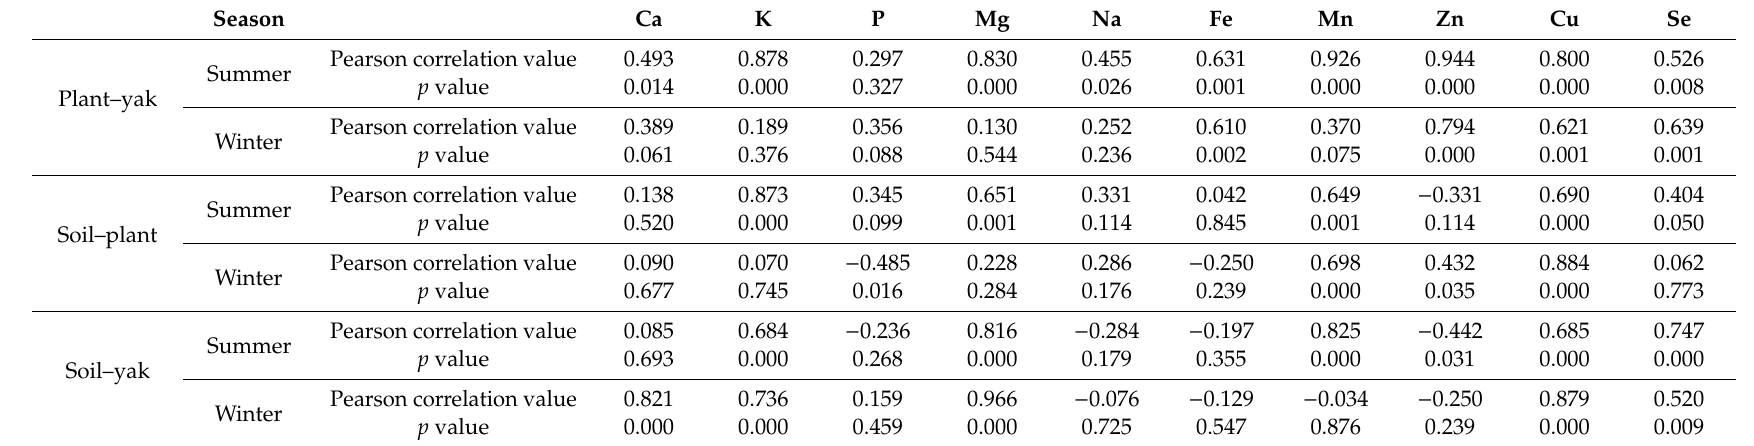
Table 7. Soil–plant–yak relationship (correlation) with respect to macro and micro mineral